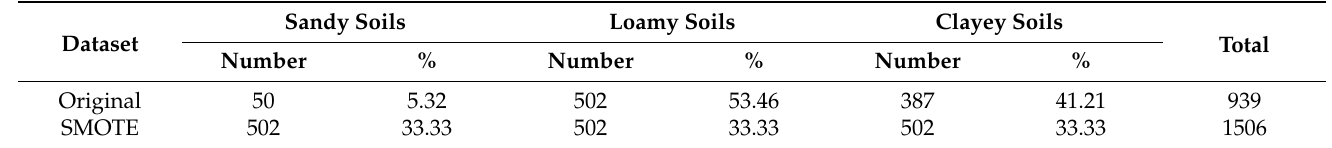
Table 1. Number of samples for each soil texture class before and after the synthetic minority over- sampling technique (SMOTE).